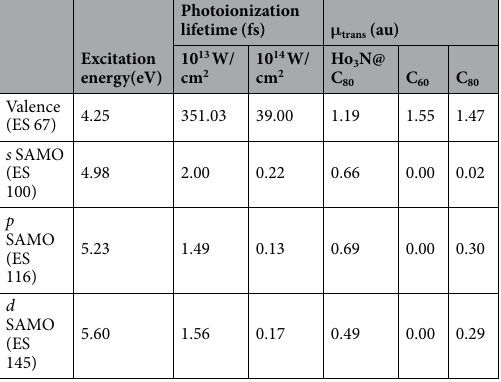
Table 2. Computed binding energies, photoionization lifetimes (in fs) for a field intensity of 10 13 and 10 14 W/cm 2 and transition dipole moments ( μ trans ) between the ground and excited states shown in Fig. 3. The photoionization lifetimes are computed for the ionization of an electron with a kinetic energy of 0.2 eV. For comparison, the computed transition dipole moments of the valence (with an excitation energy around